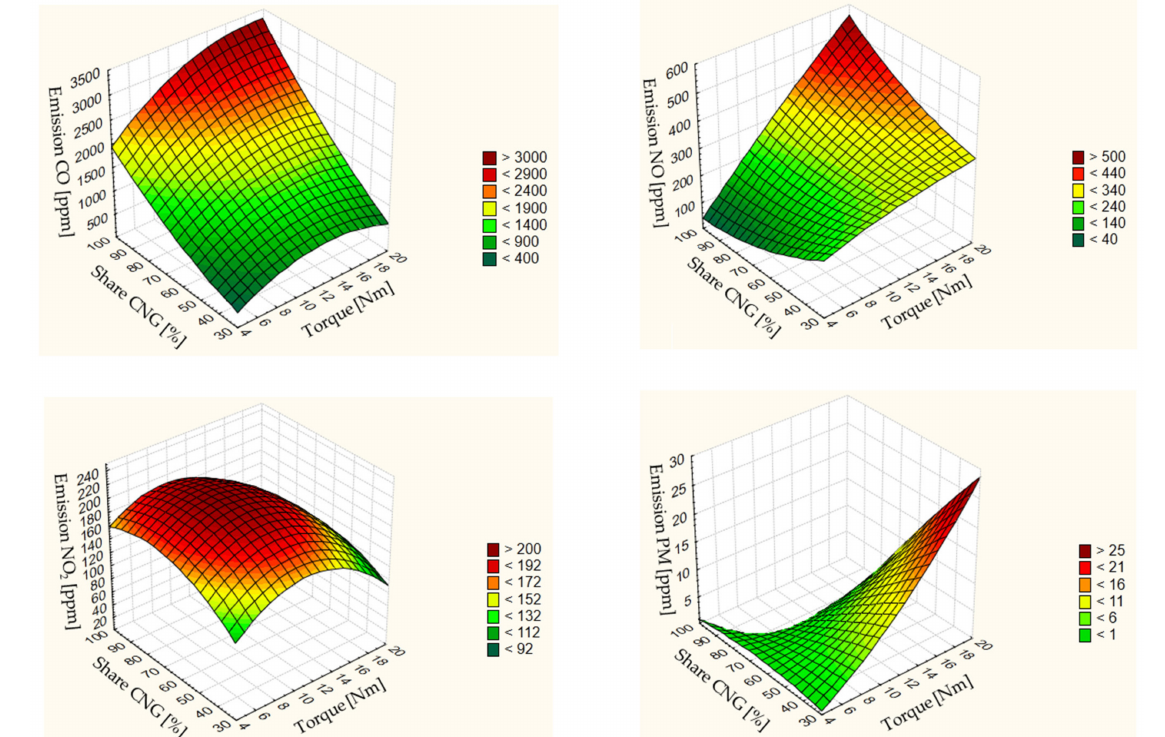
Figure 9. Emission of CO, NO, NO 2 , and PM in the mixture of RME and CNG at variable load.